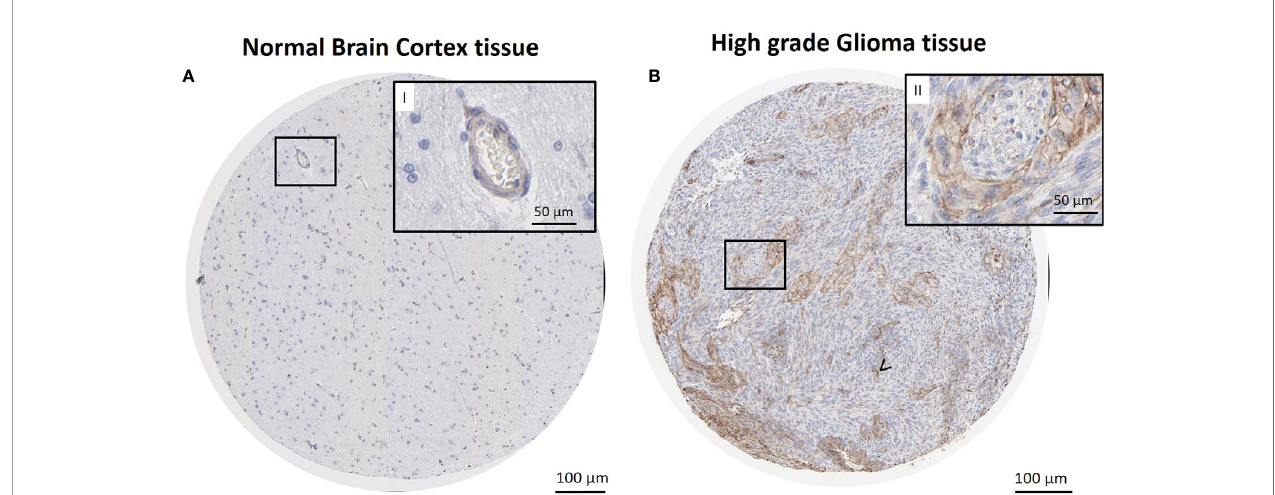
FIGURE 3 | Immunohistochemical reaction for Cav-1 in normal brain cortex tissue (control) and GB tissue. Sections retrieved from The Human Protein Atlas project. Representative sections of high-grade glioma show a strong cytoplasmatic/membranous positivity of Cav-1 in tumour cells (B) , also in higher magni fi cation (B, II) . Strong positivity is also observed in microvasculature areas (B) , arrow <). No reaction is observed in glial cells of normal brain cortex tissue (A) . Lower expression of Cav-1 in endothelial cells and capillaries was also evident in the normal tissue control material (A, II) . Scale bars: (A, B) 100 µm; ( I-II , higher magni fi cation) 50